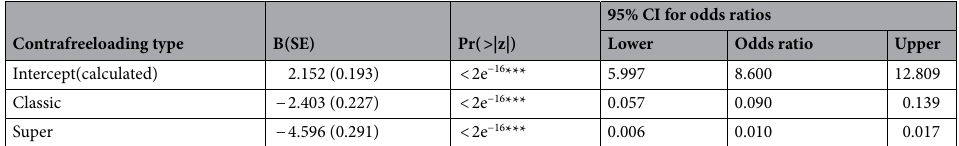
Contrafreeloading